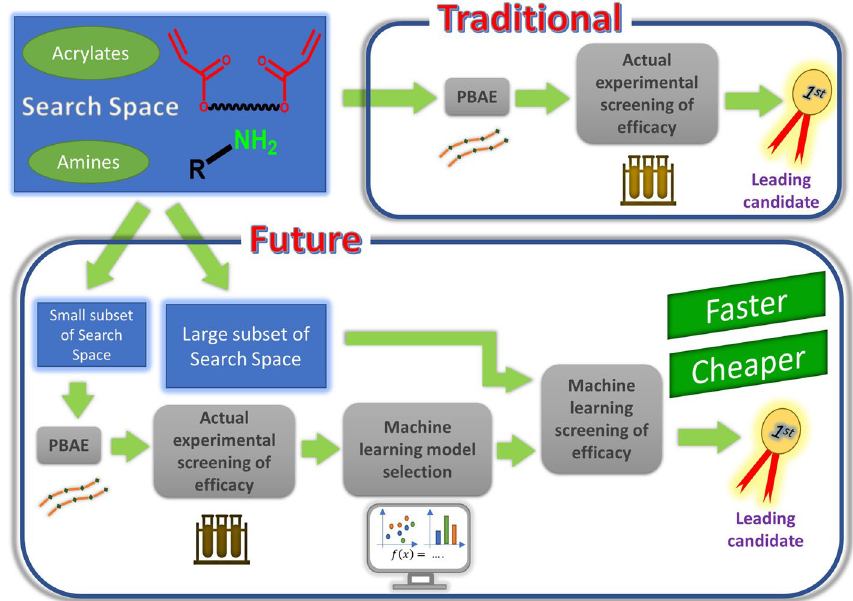
Figure 1. Schematic representation of machine learning driven drug development